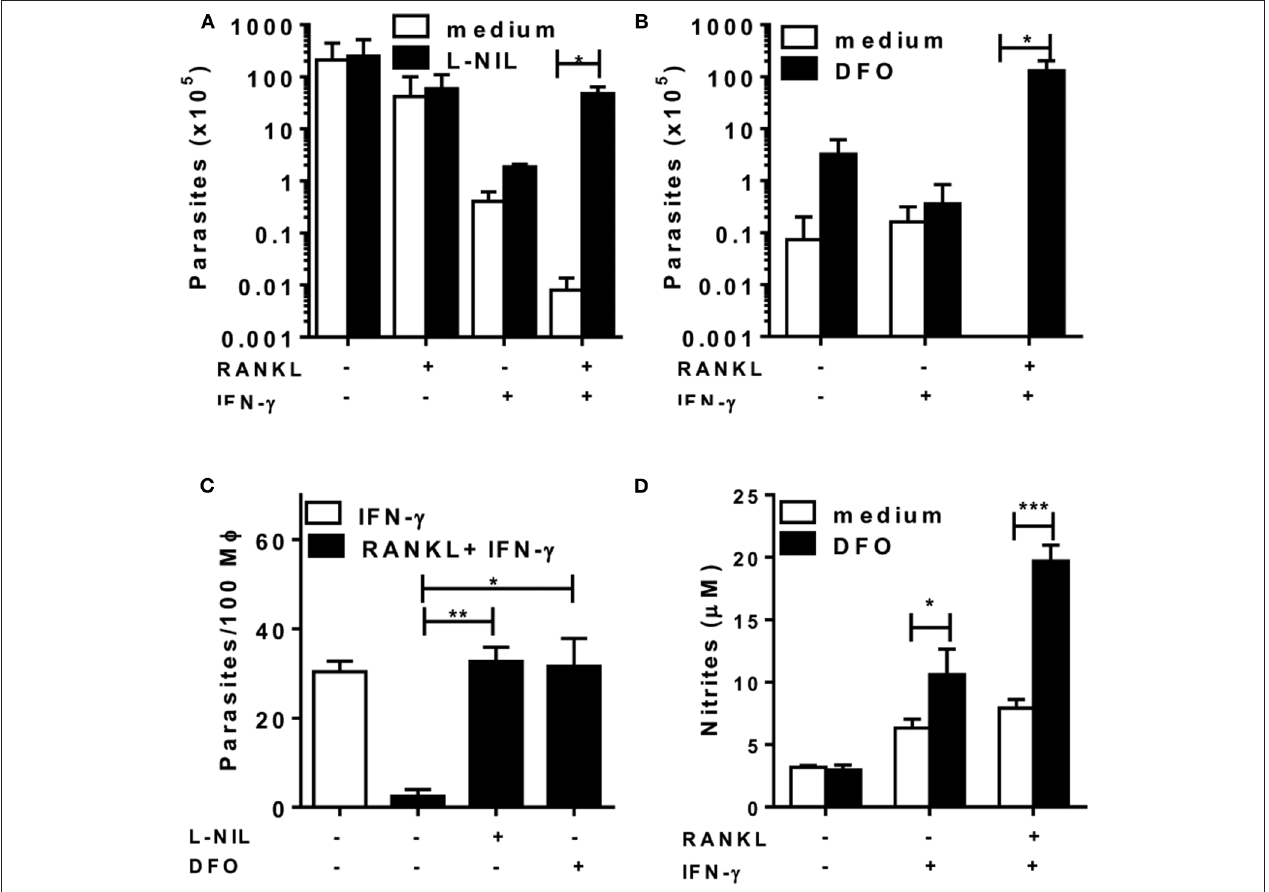
FIGURE 5 | RANKL and IFN- γ induce L. major -parasite control. Inflammatory (B6) macrophages were infected with L. major (1:10) during 24h and then treated with RANKL, IFN- γ , L-NIL (1mM) or DFO (100 µ M) during 72h. (A–C) Parasitic burden was determined as (A,B) released promastigotes (parasites/mL) or (C) by counting amastigotes within macrophages. (D) Culture supernatants were tested for NO production by the Griess method. Results are expressed as means and S.E.M. Significant differences between macrophages treated without and with L-NIL or DFO were analyzed by t -test and indicated for * P < 0.05, ** P < 0.01, and *** P < 0.001. Data are representative of 2 independent